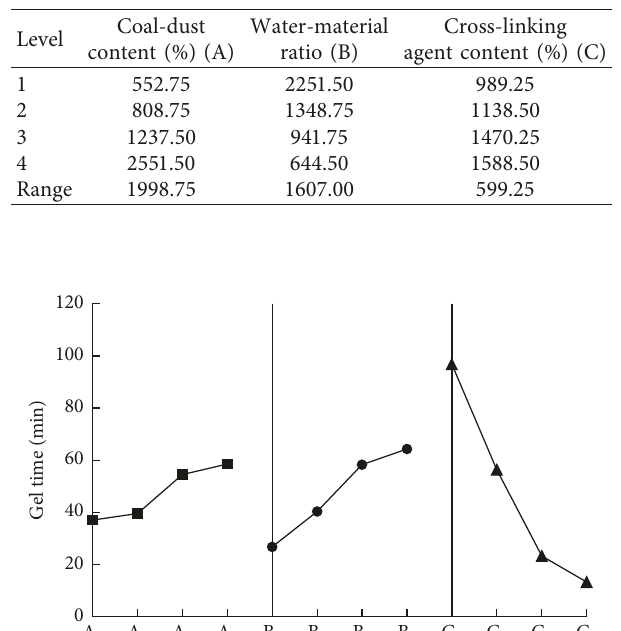
Table 6: Range analysis of the influencing factors of gel time.